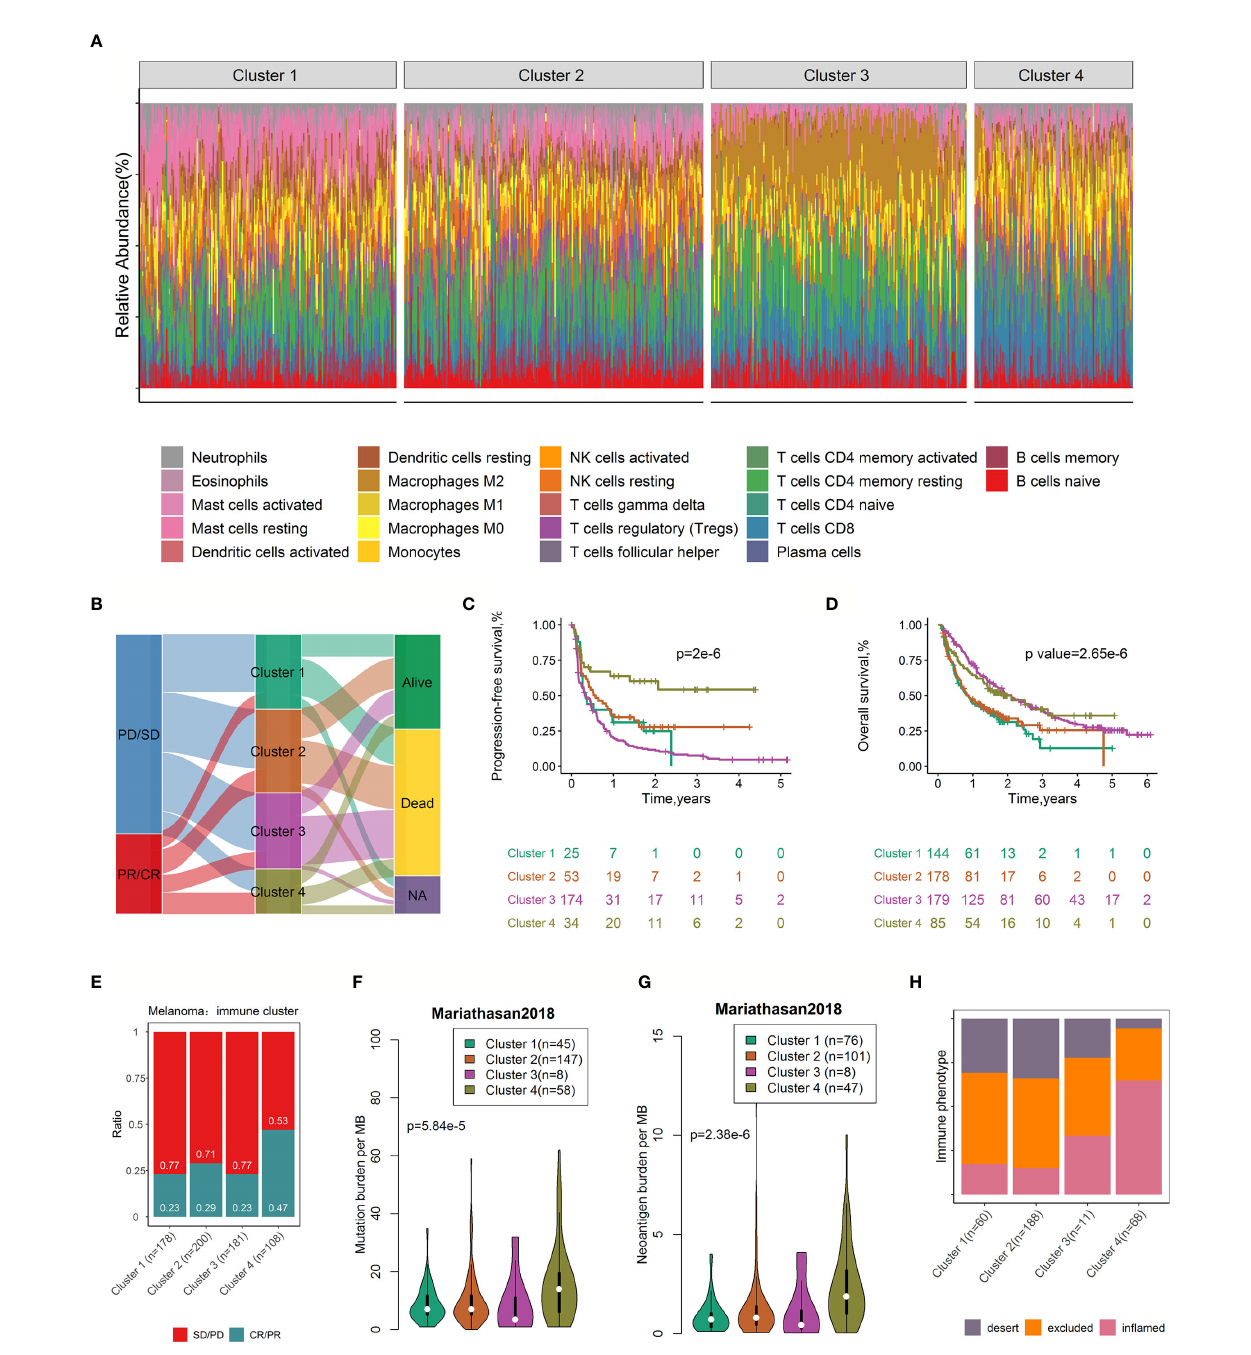
FIGURE 7 | Consensus clustering of 782 samples based on immune cell ratios. Stacked bar charts of immune cell proportions by immune cluster (A) . Alluvial diagram of immune cluster distribution in patients with different immune clusters, responses to ICI therapy, and OS outcomes (B) . Survival plots by immune cluster separately for OS (C) and PFS (D) . P-values calculated with log-rank tests are represented. Spine plots depicting the correlation between immune clusters and response in melanoma (E) . Differences in mutation burden (F) and neoantigen burden (G) among distinct immune clusters (ANOVA test, p < 0.0001). Spine plots depicting the correlation between immune clusters and immune phenotype (H) . OS, overall survival; PFS, progression-free